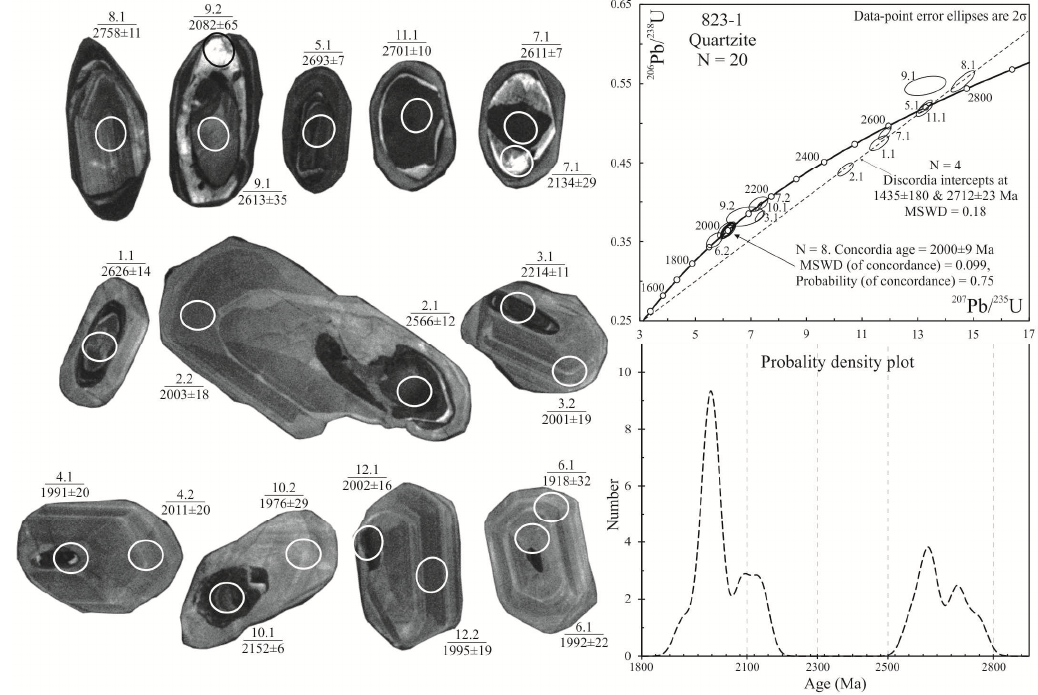
Figure 7. CL images and age of zircons from the garnet quartzite, sample 823-1.